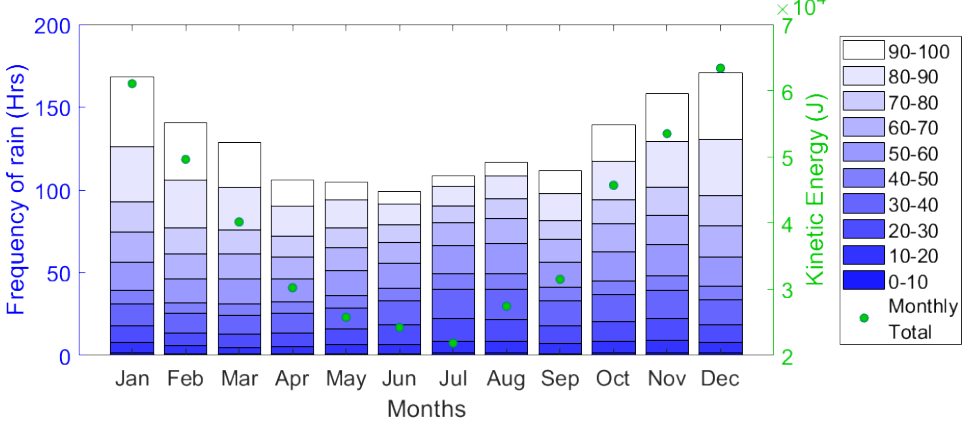
Figure 13. The number of rain hours and E K for each impact speed bin for each